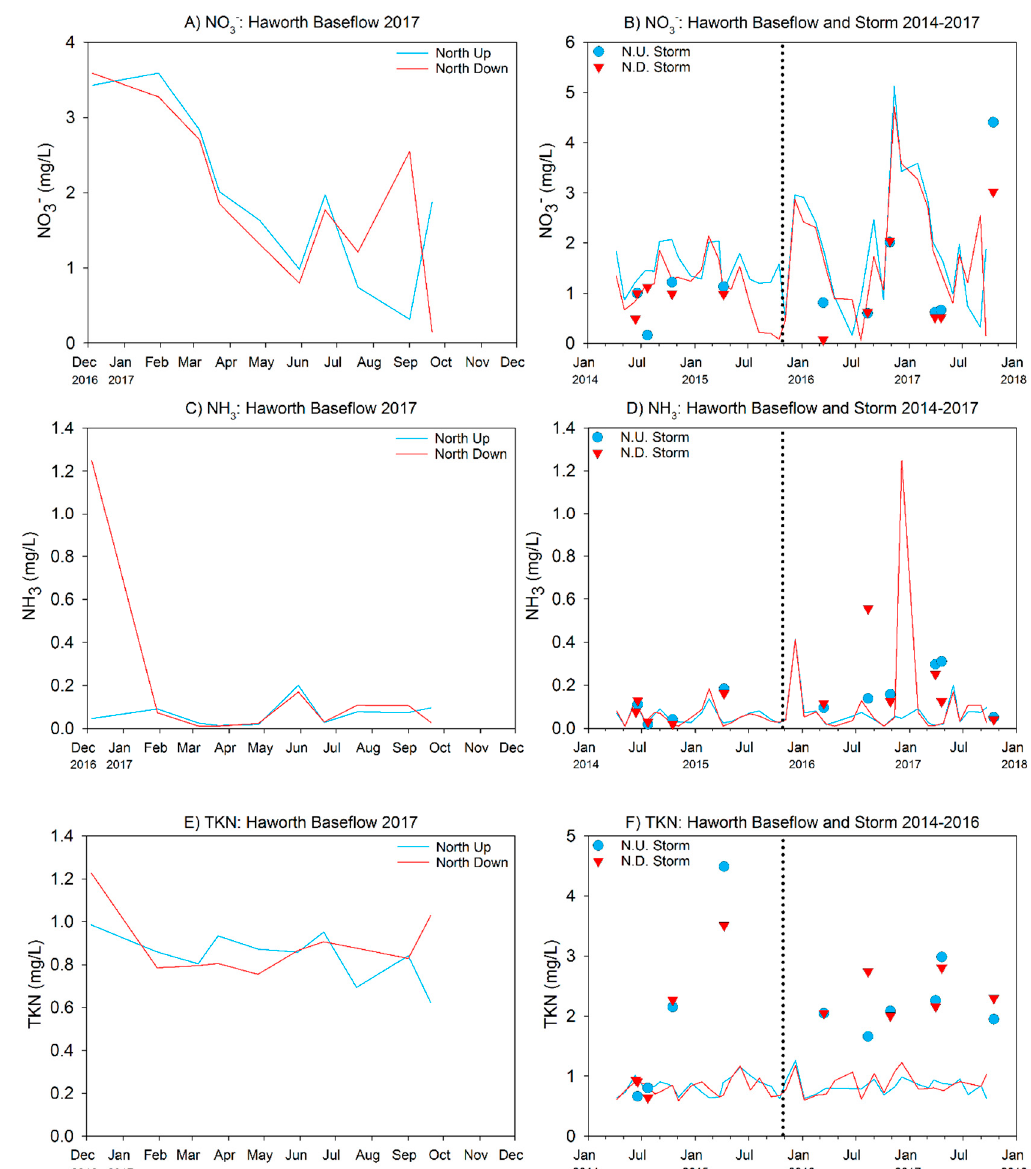
Figure 8. Nitrate (NO 3 − ), ammonia (NH 3 ), and total Kjeldahl nitrogen (TKN) concentrations measured at the Haworth wetland for 2017 ( A , C , E ) and total project history ( B , D ,E). See Figure 7 caption for more explanation.